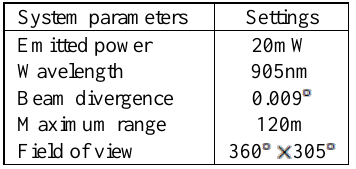
Table 1. Main system parameters of Faro Focus 3D 120